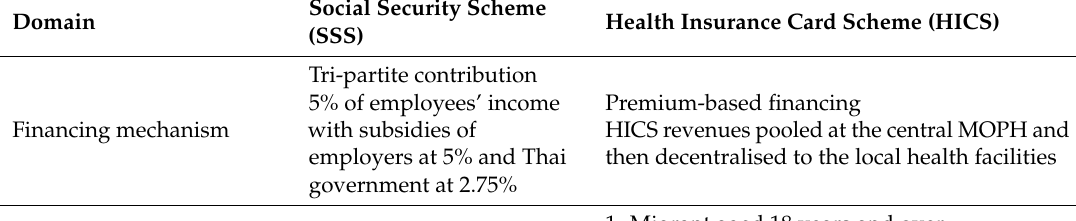
Table 2. The health insurance schemes for migrants and